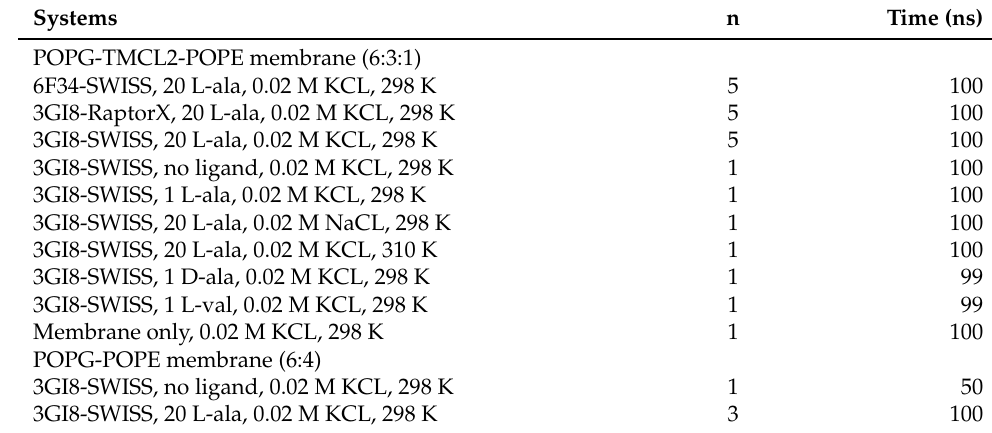
Table 1. System details. n indicates the number of runs per